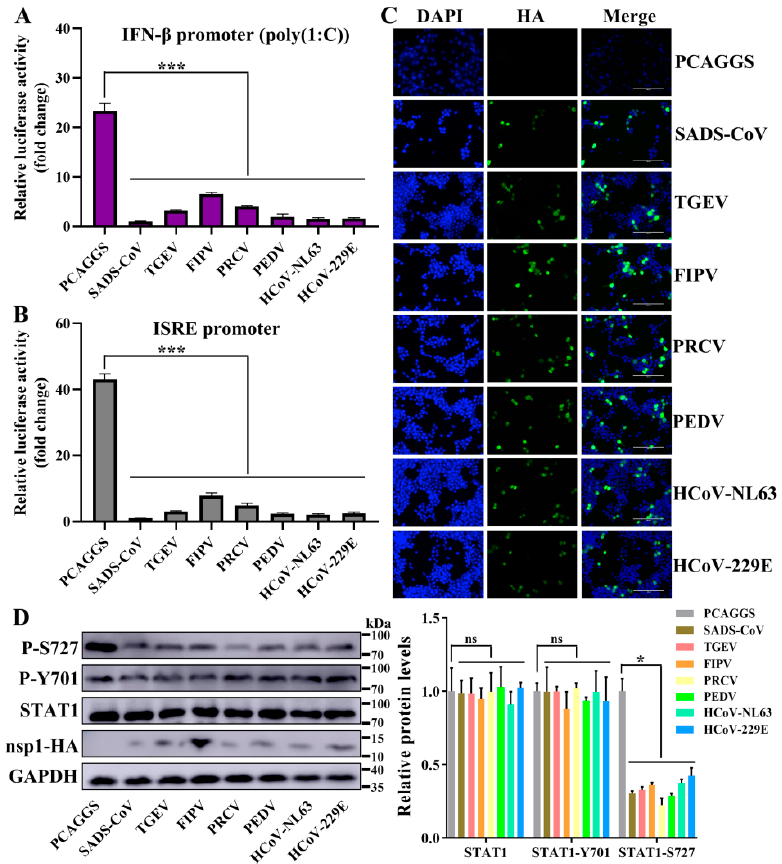
Figure 7. α -CoV nsp1 reduces interferon (IFN)-related gene expression. ( A , B ) HEK-293T cells were transfected with a Luc reporter plasmid ([A]; IFN- β promoter, [B]; ISRE promoter) and an expression plasmid encoding a full-length α -CoV nsp1 protein of SADS-CoV, TGEV, FIPV, porcine respiratory coronavirus (PRCV), PEDV, HCoV-NL63 or HcoV-229E. At 8 h post-transfection, the cells were treated with a viral poly(I:C) (A) or IFN- α (B), and the luciferase activity was measured 16 h later. The data are presented as the means ± SD ( n = 3). Asterisks indicate statistical significance as determined by Student’s t -test. ***, p < 0.001. ( C ) Transfected HEK-293T cells were fixed at 24 h post-transfection, and indirect immunofluorescence assays were performed with a monoclonal antibody against the HA protein. Original magnification × 200 (scale bars 100 µ m). ( D ) Western blot analysis of extracts from HEK-293T cells that were transfected with the mock control or α -CoV nsp1 for 24 h. The analysis was performed with antibodies against STAT1, STAT1 phosphorylation on S727, STAT1 phosphorylation on Y701, HA, and GAPDH (left). The gray scale values of the protein bands were analyzed with ImageJ (right). The data are presented as the means ± SD ( n = 3). Asterisks indicate statistical significance as determined by Student’s t -test. Ns: Not significant; *, p < 0.05.